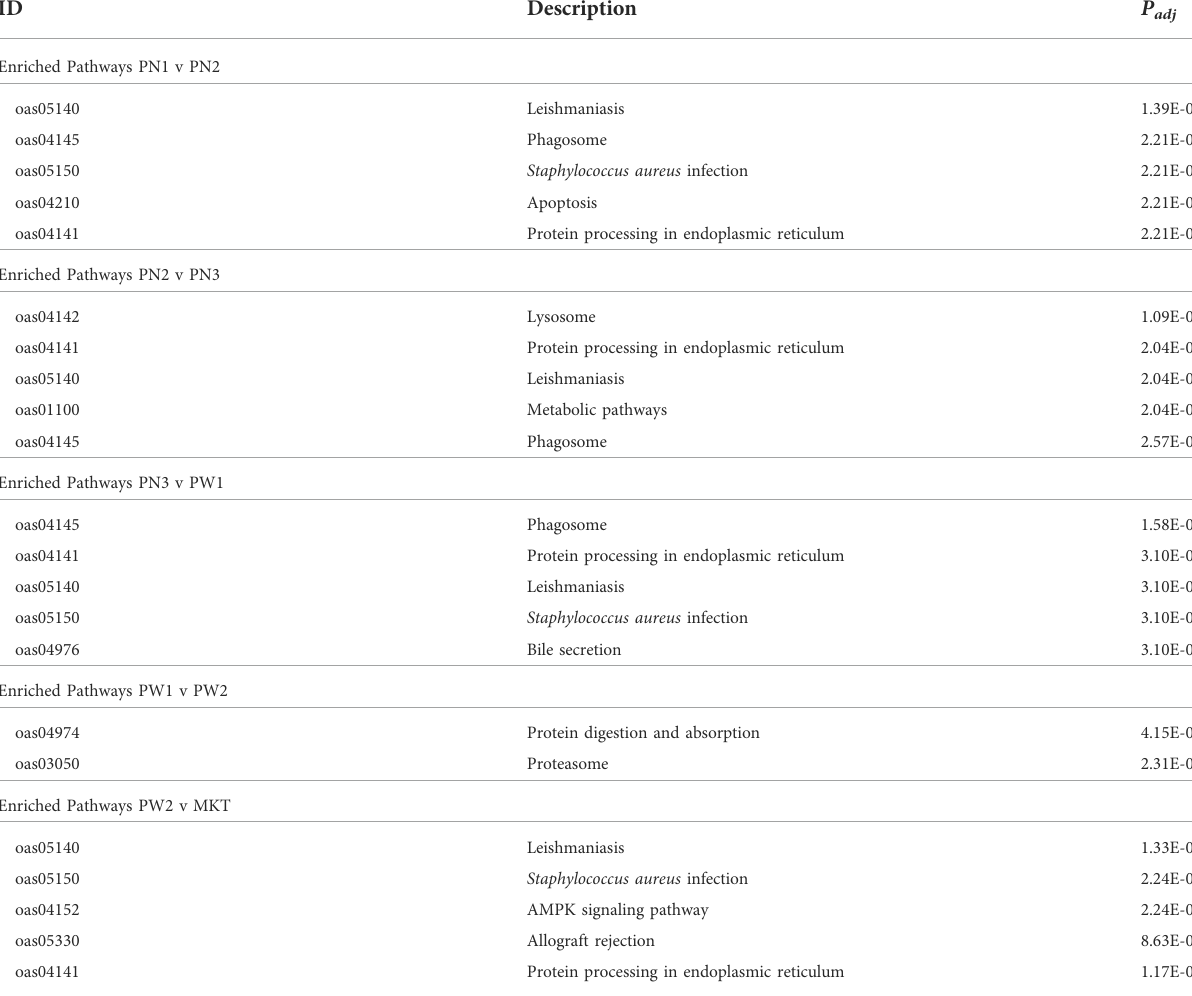
TABLE 7 Summary of enriched KEGG pathways from each comparison.